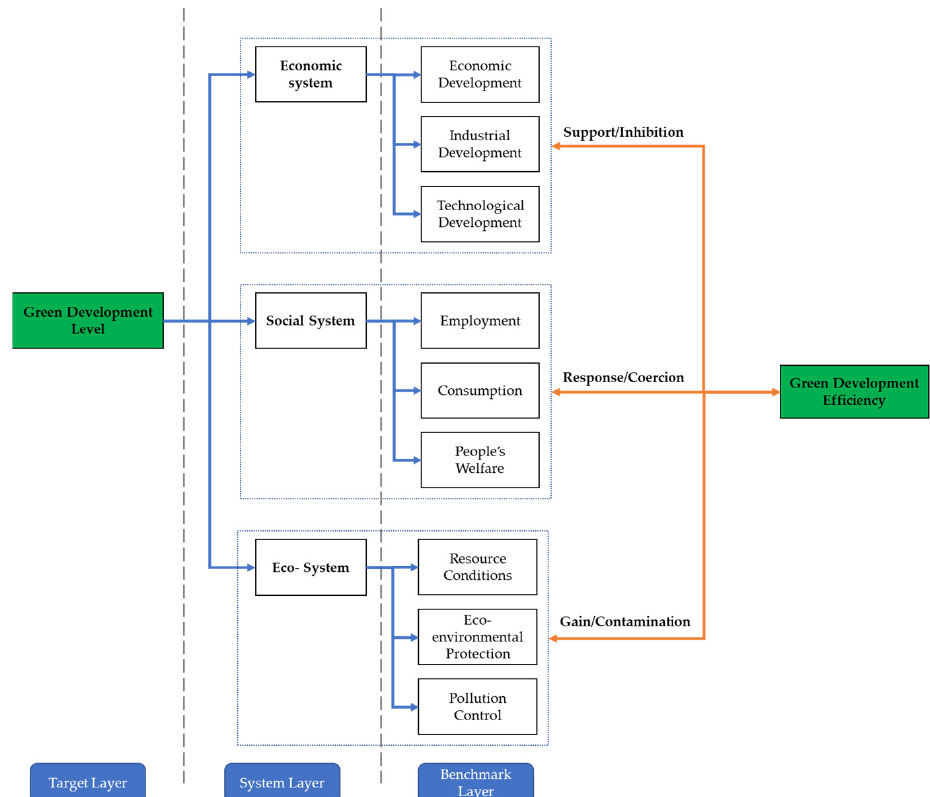
Figure 1. The theoretical framework of green development theory.